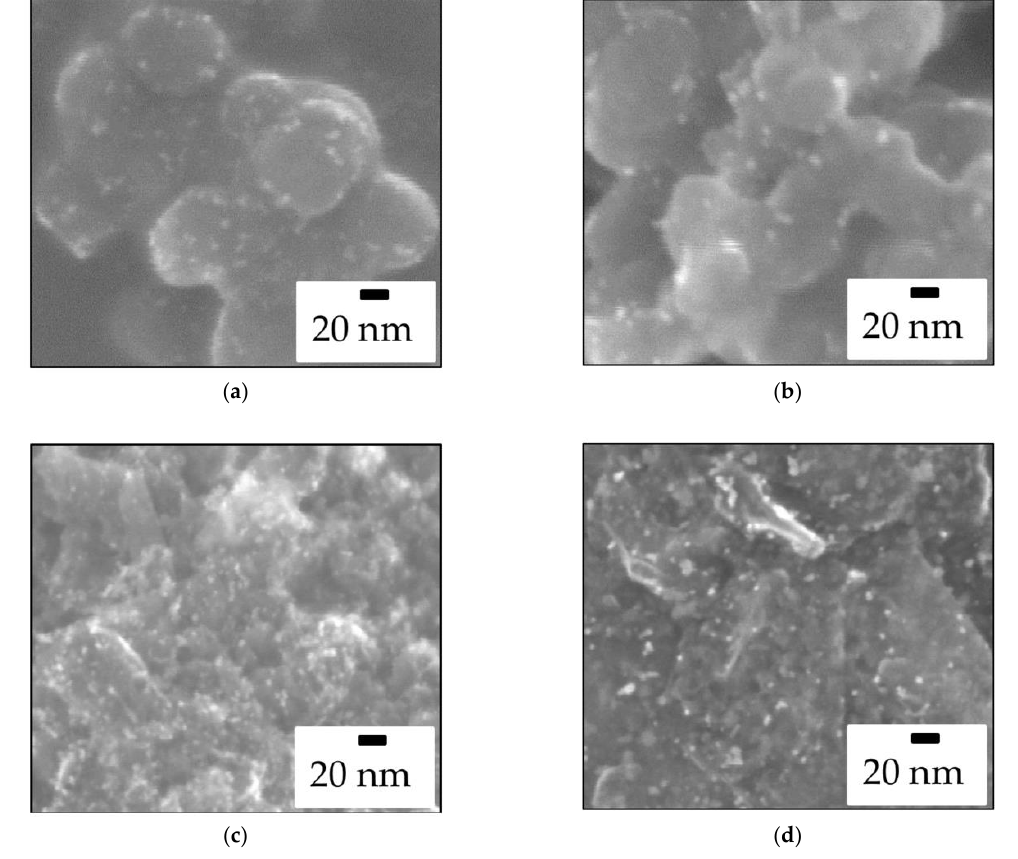
Figure 5. Carbon black loaded with Pt nanoparticles before ( a ) and after ( b ) 20,000 cycles, and nanographene loaded with Pt nanoparticles before ( c ) and after ( d ) 20,000 cycles of high electric potential durability tests.